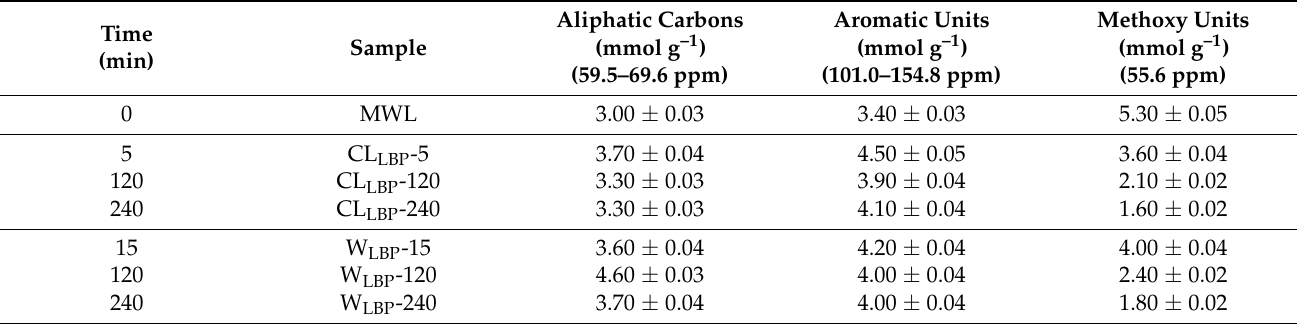
Table 2. Comparison of aliphatic carbons, aromatic and methoxy units content (mmol g –1 ) in CL LBP and W LBP at different liquefaction times as determined by quantitative 13 C